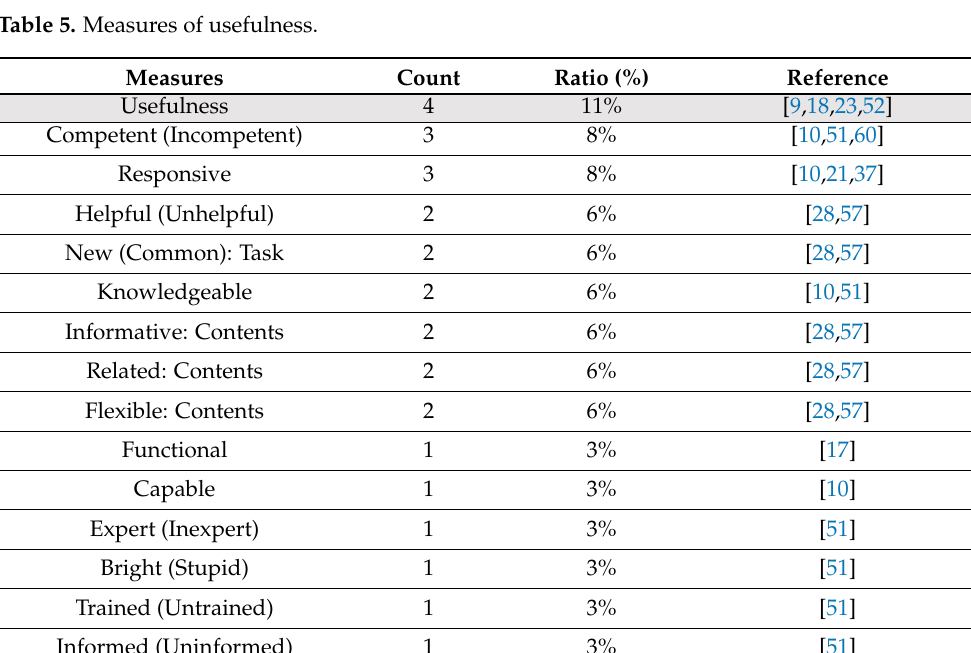
Table 5. Measures of usefulness.